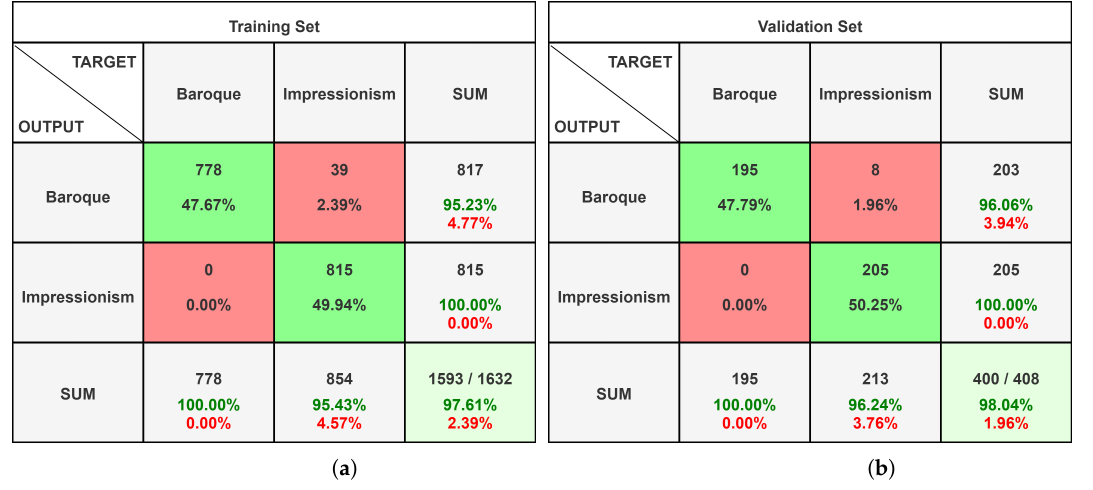
Figure 8. Confusion matrices of the painting dataset analysed on InceptionResNet-V2 with Google Colab. ( a ) Training set confusion matrix; ( b ) validation set confusion matrix.